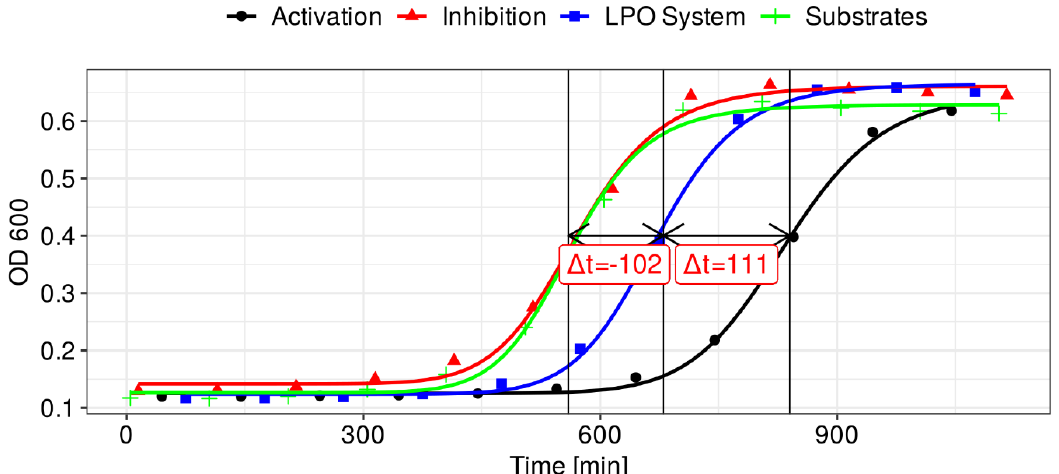
Figure 7. Examples of growth curves recorded spectrophotometrically at 600 nm. The green line shows the growth of S. mutans in the presence of substrates of the LPO system (H 2 O 2 and SCN – ions). The blue line shows the growth in the presence of the complete LPO system (H 2 O 2 – SCN – LPO). The black line shows microbial growth in the presence of the complete LPO system and 12 µM (-)-epicatechin. Vertical lines indicate the time taken by the sample containing the activated LPO system and the LPO system to reach half the logarithmic growth phase in the graph. The red line shows microbial growth in the presence of the complete LPO system and 760 µM (-)-epicatechin.